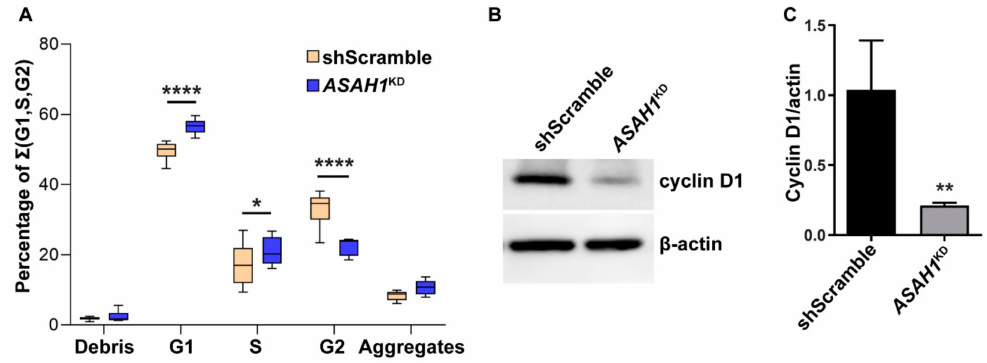
Figure 3. Acid ceramidase (AC) depletion induces G1 / S cell cycle arrest of ASAH1 KD cells. ( A ) Cell cycle progression was assessed using propidium iodide and flow cytometry analysis. The graph gives percentages of G1, S, and G2 as a total of 100% with relative percentages of debris and aggregates, in ASAH1 KD and shScramble cells. * p = 0.02, **** p < 0.0001 compared to shScramble ( n = 6,